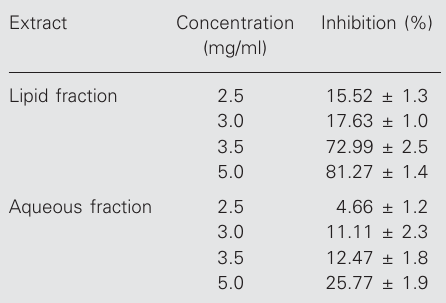
Figure 1. Effect of topical appli- cation of Ipomoea imperati lipid and aqueous fractions on croton oil- (200 µg/ear) (A) and arachi- donic acid-induced (0.5 mg/ear) (B) mouse ear edema. The posi- tive control dexamethasone (217 µg/ear) induced a maximum inhi- bition of 52.0 ± 1.0% and ac- etone was the negative control. Each column is the mean of 5 mice, and the bars indicate the SEM. *P<0.05 compared to con- trol (Tukey test).